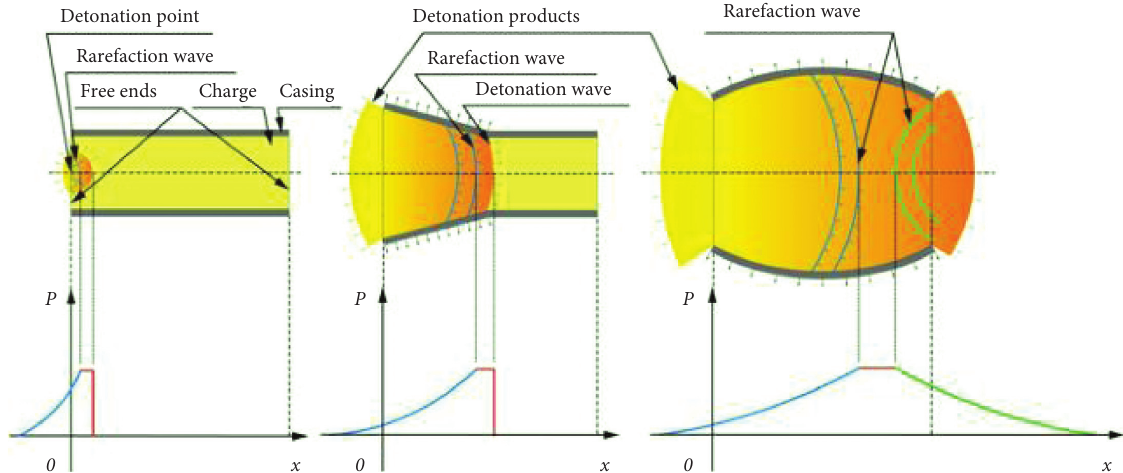
Figure 7: Sparse wave propagation diagram at two free ends of the sleeve.